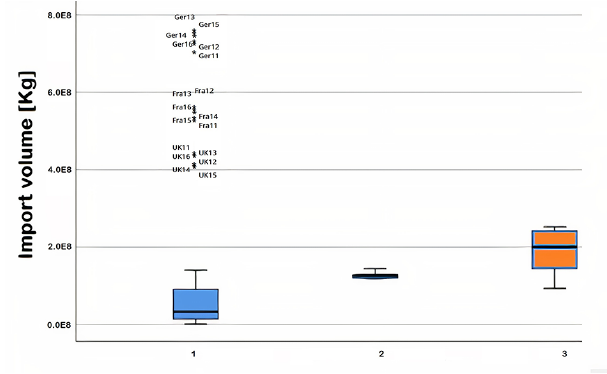
Figure 10. Post-crisis box diagram of import variable according o the clusters of the first two-stage clustering level (source: own